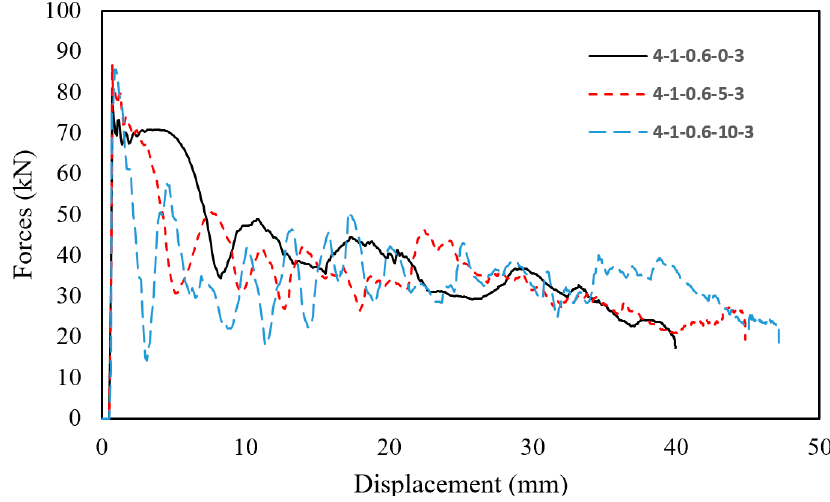
Figure 10. Plot of force-displacement curves of panels 4 – 1 – 0.6 – θ –3.